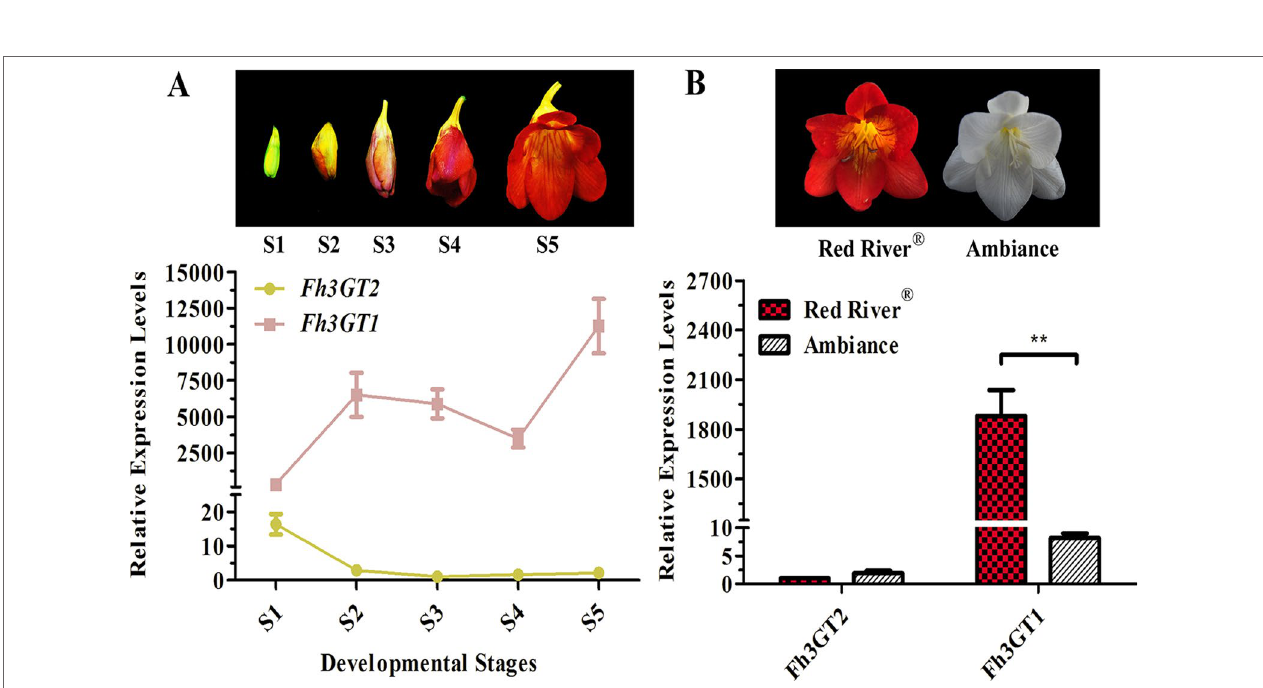
FIGURE 5 | Expression profiles of Fh3GT2 and Fh3GT1 in different flower developmental stages and different Freesia cultivars. (A) Expression levels of Fh3GT2 and Fh3GT1 in flowers at different developmental stages. S1 – S5 represented the different developmental stages of flowers. (B) Expression profiles of Fh3GT2 and Fh3GT1 in Freesia cultivar Red River ® and Ambiance. Data represented the means ± SD of three biological replicates. T test was carried out to analyze the significant difference (** P <